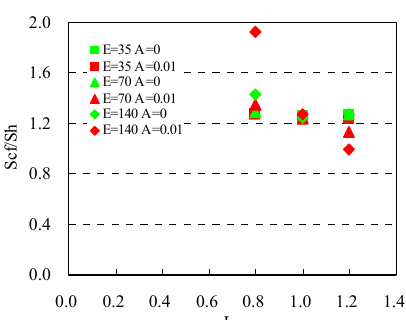
Fig. 11. Normalized burning velocities of cellular flames at Le = 0.8 through 1.2 and E = 35, 70 and 140 under the adiabatic and non-adiabatic conditions.